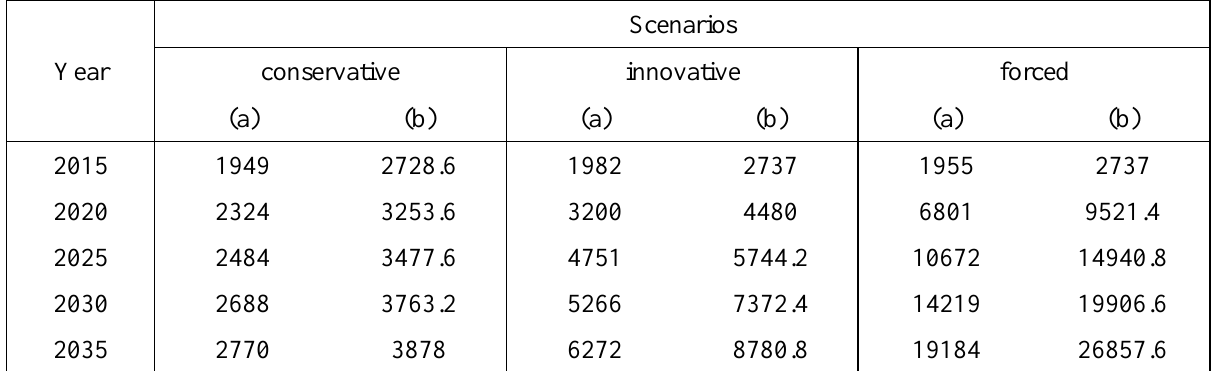
Table 7. Scenarios for development of the Russian peat industry: estimates of production capacity according to (a) Voskoboinik 2015 and (b) the present study. Units: thousands of tonnes.